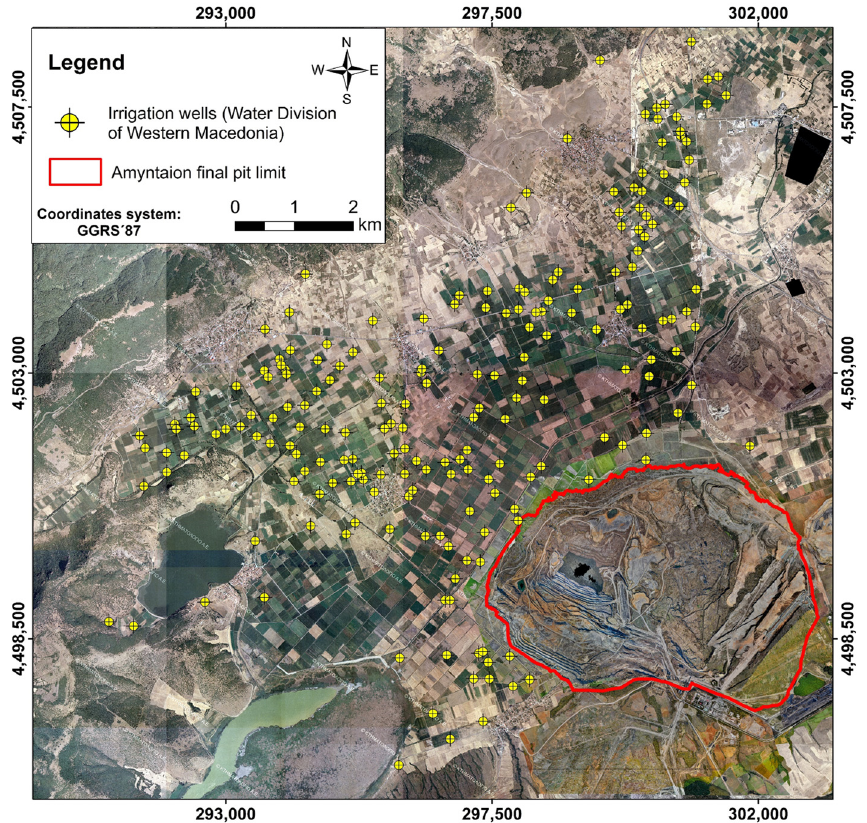
Figure 8. Distribution of the ca. 600 nos. irrigation wells in the Amyntaion flood plain (yellow shapes). The Amyntaion mine is shown in the red envelope.